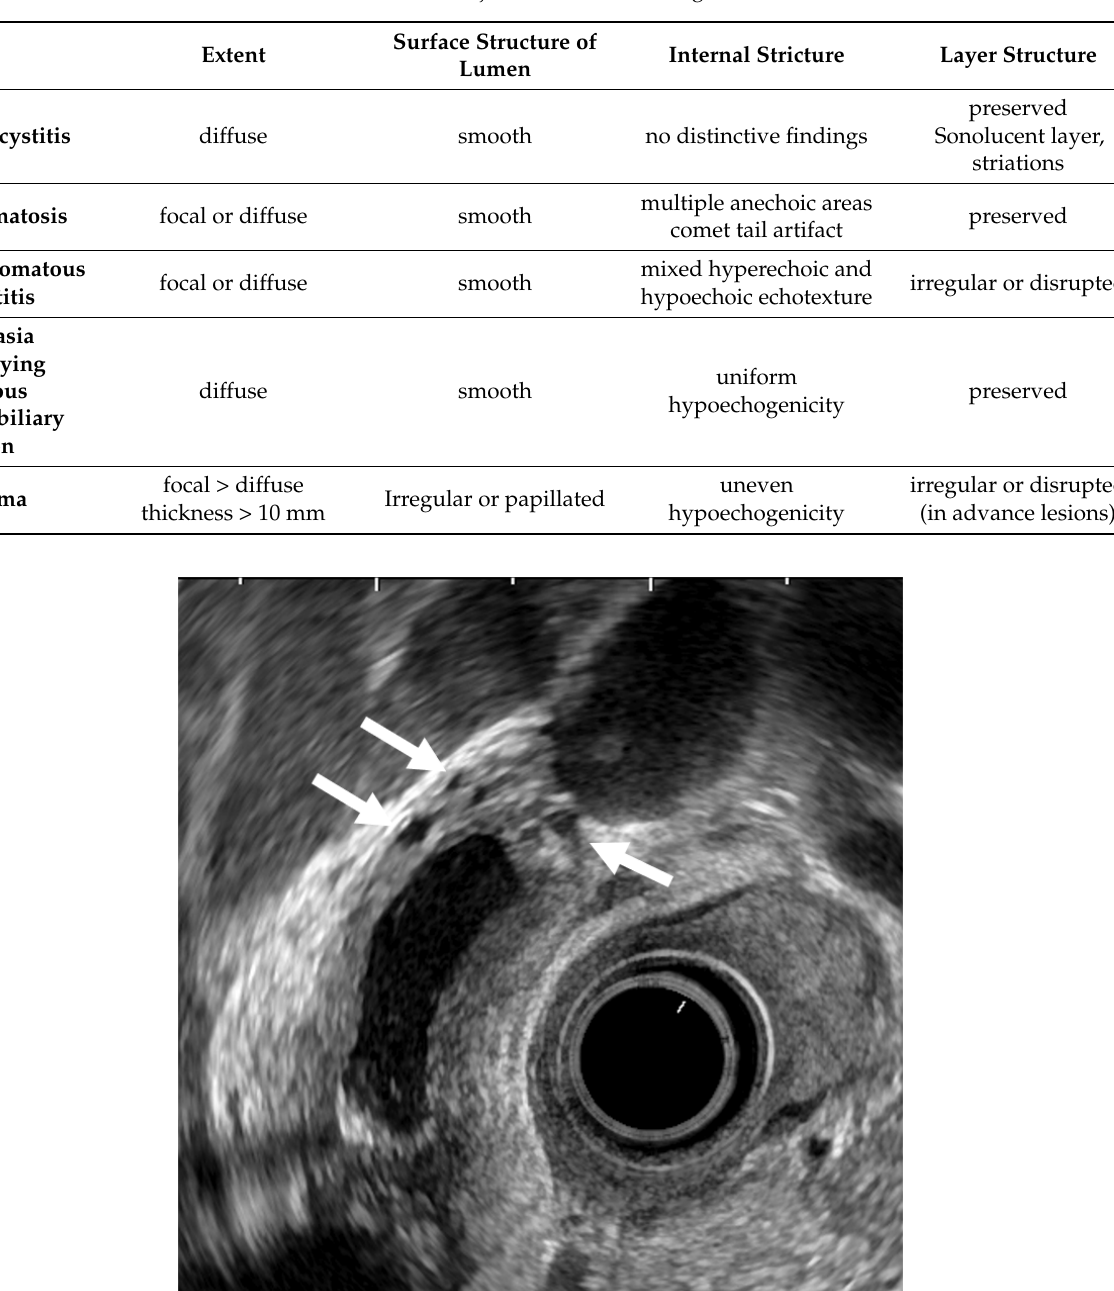
Table 4. EUS features of major GB wall-thickening lesions.